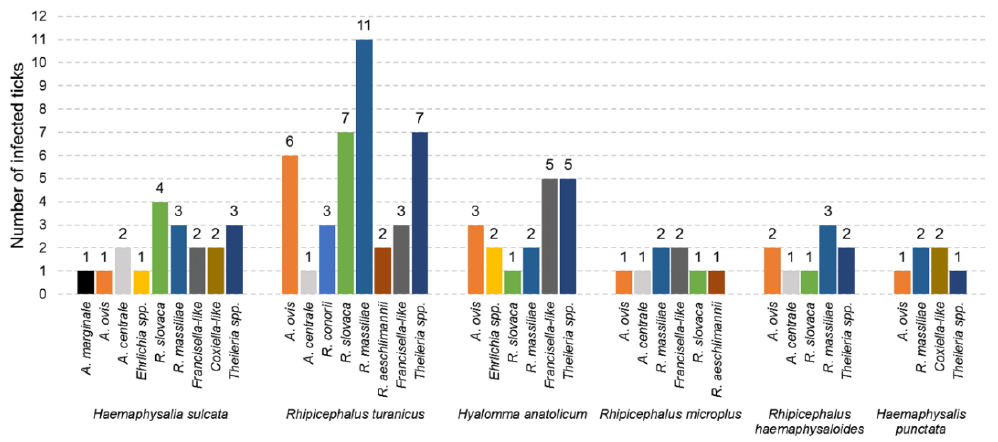
Figure 5. Number of ticks infected with microorganisms from small ruminants in the FATA of Pakistan. The species of tick is shown at the bottom while the number of individual species of ticks infected with the microorganism species ( x axis) is shown above each bar ( y axis) of the chart.